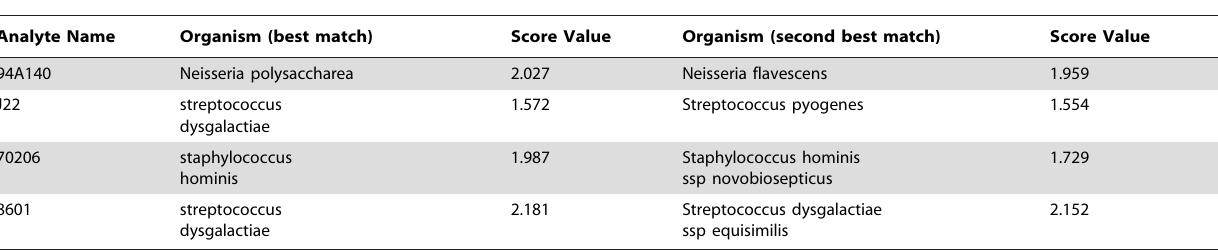
Table 1. The four isolates wrongly identified by MALDI-TOF MS.